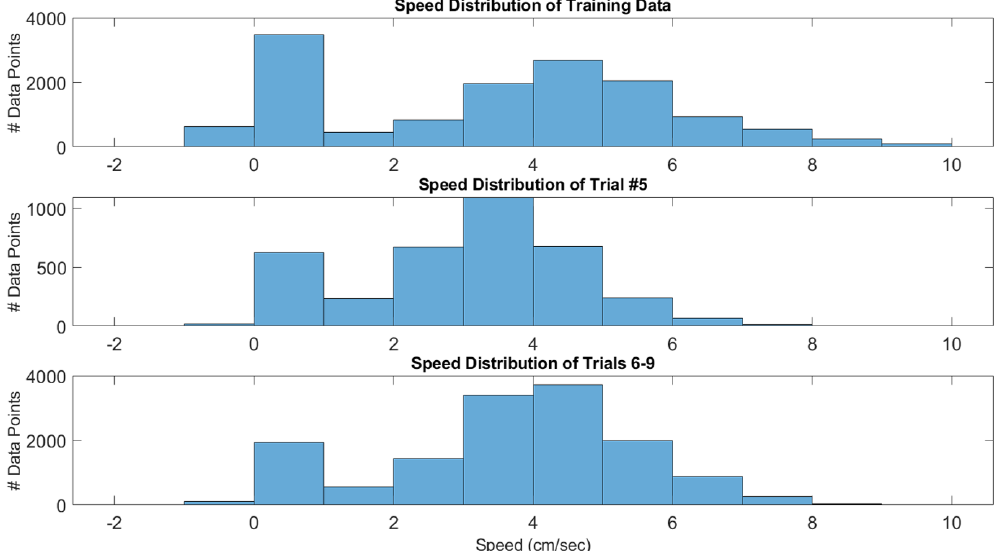
Figure 11. Ground Truth Speed Distributions: Each bin has a width of 1 cm/s. Note that the negative speeds are a result of the perturbation that occurs in the ground truth refinement algorithm. ( Top Plot ) Speed distribution of the training data (trials 1–4). ( Middle Plot ) Speed distribution of trial #5. Trial #5